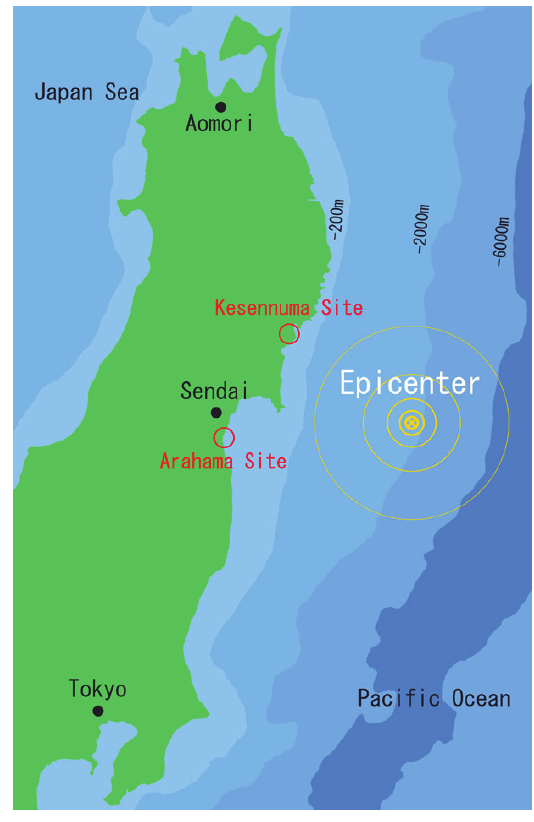
Figure 5. Project sites of Arahama and